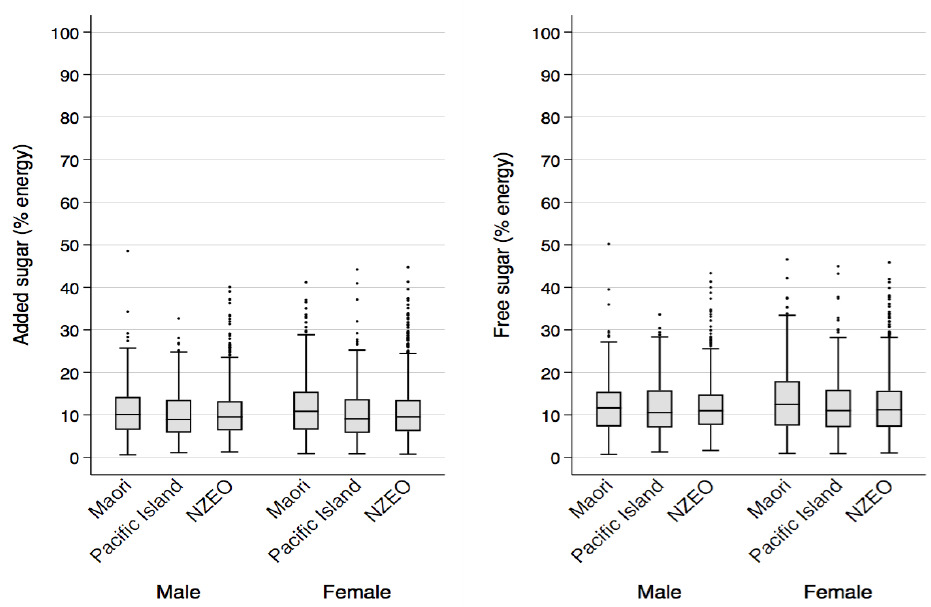
Figure 2. Box plots of added and free sugars intakes (as a percentage of energy intake) in New Zealand adults aged 15 years and older in 2008/09 by sex and ethnicity. The middle line is the median, the box represents the 25–75th percentiles, and the points outside the ‘whiskers’ are points that were greater than 1.5 times the interquartile range above the upper quartile. NZEO = New Zealand European and Others.